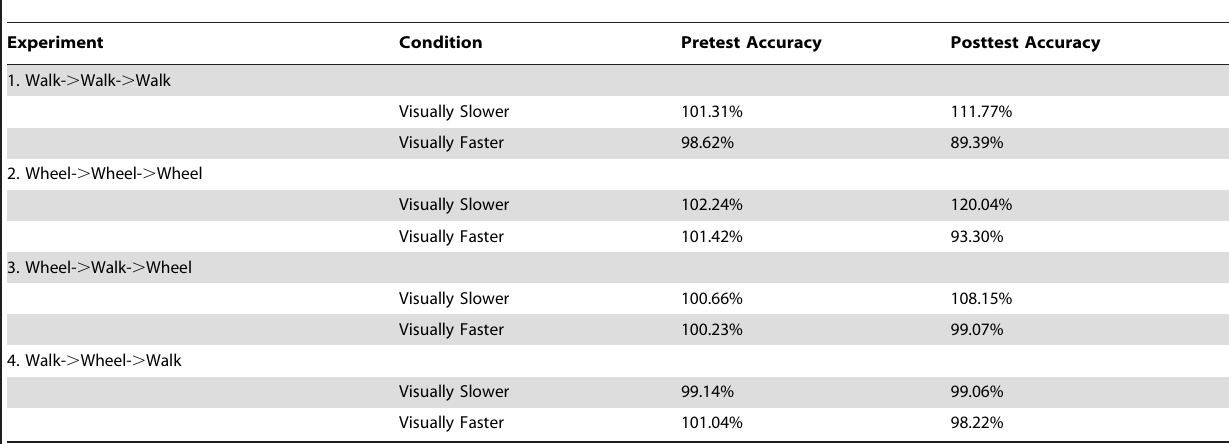
Table 2. Summary of results from Experiments 1–4 with real world pretest and